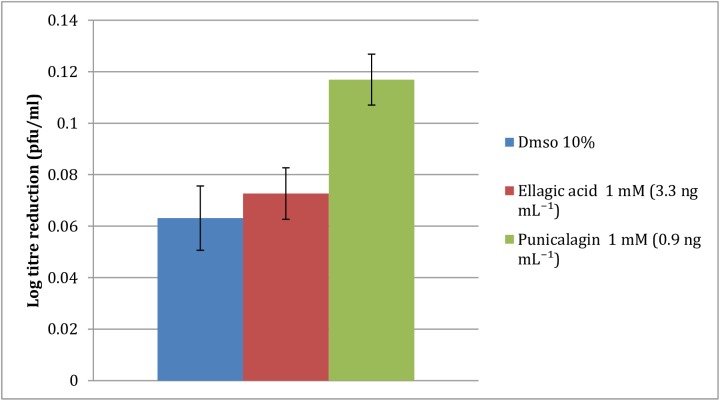
Virucidal log reduction due to the main punicalagin versus ellagic acid solubilised in 10% aqueous DMSO (n = 4 ± SD).Results show no activity of ellagic acid, whereas punicalagin was significantly greater than control.